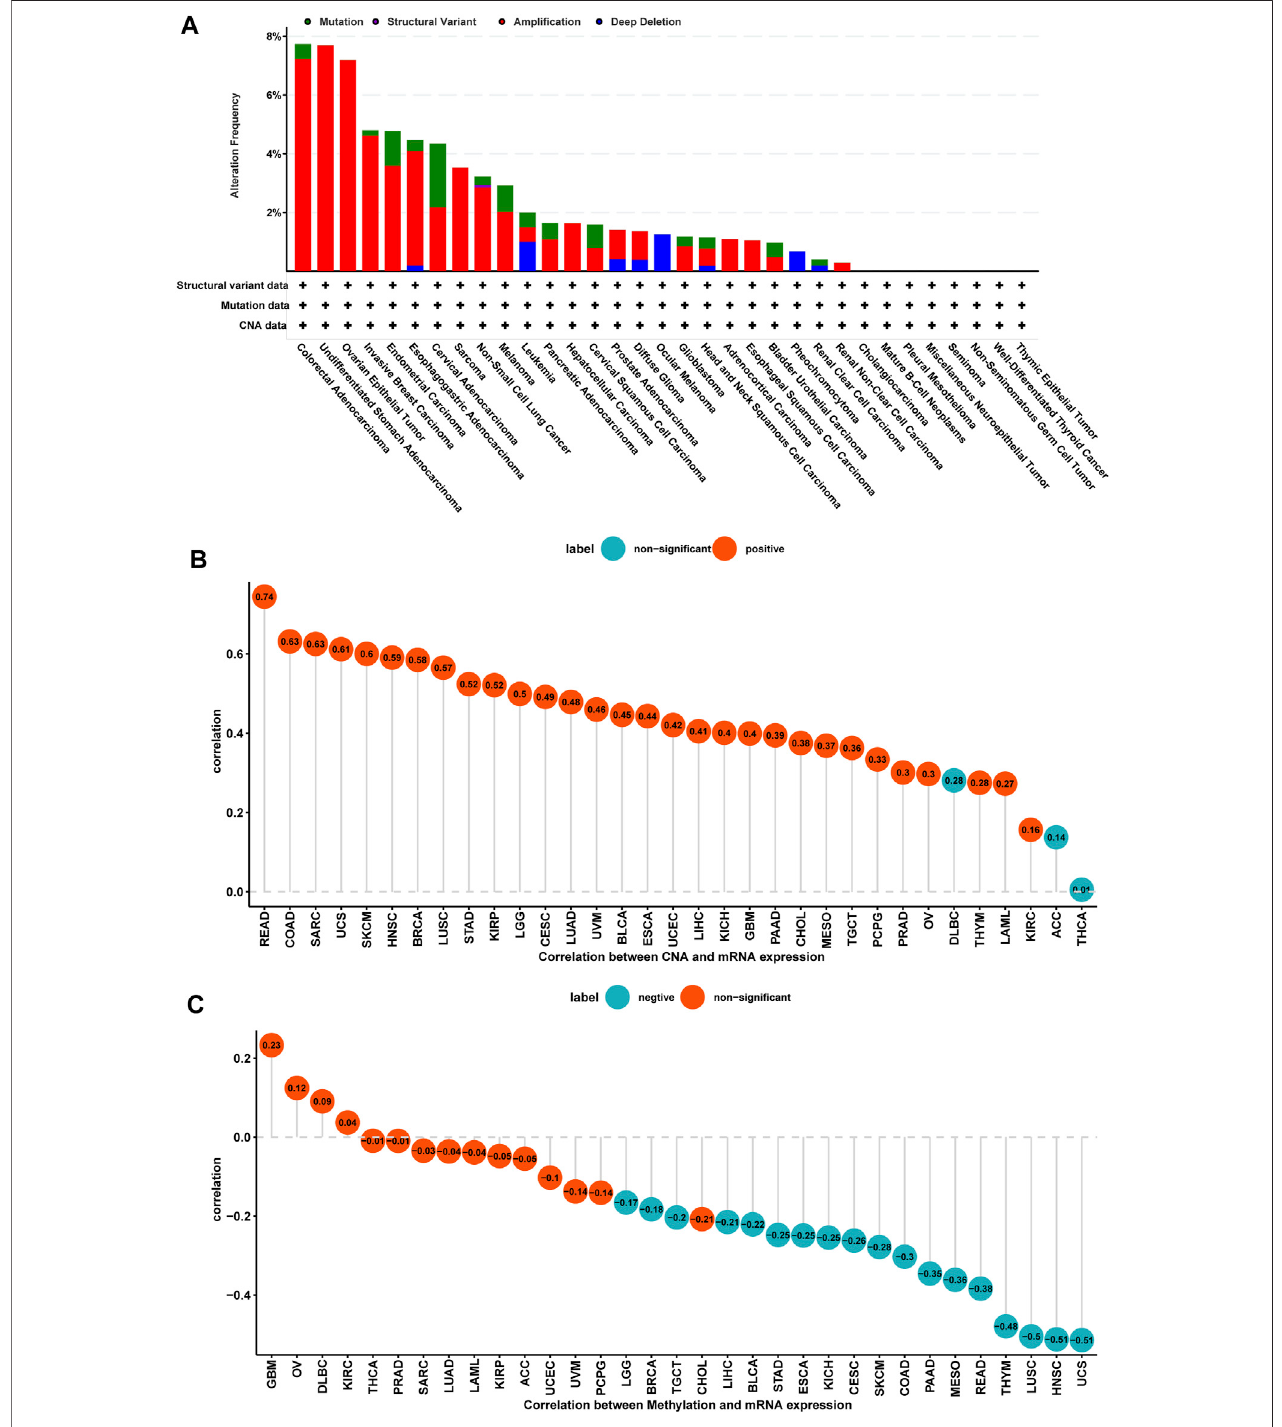
FIGURE 3 | Gene alteration of TPD52L2. (A) Mutation and CNA status of TPD52L2 in TCGA-pan-cancer using the cBioPortal database. (B) Correlation between TPD52L2 expression and CNA. (C) Correlation between TPD52L2 expression and DNA methylation.